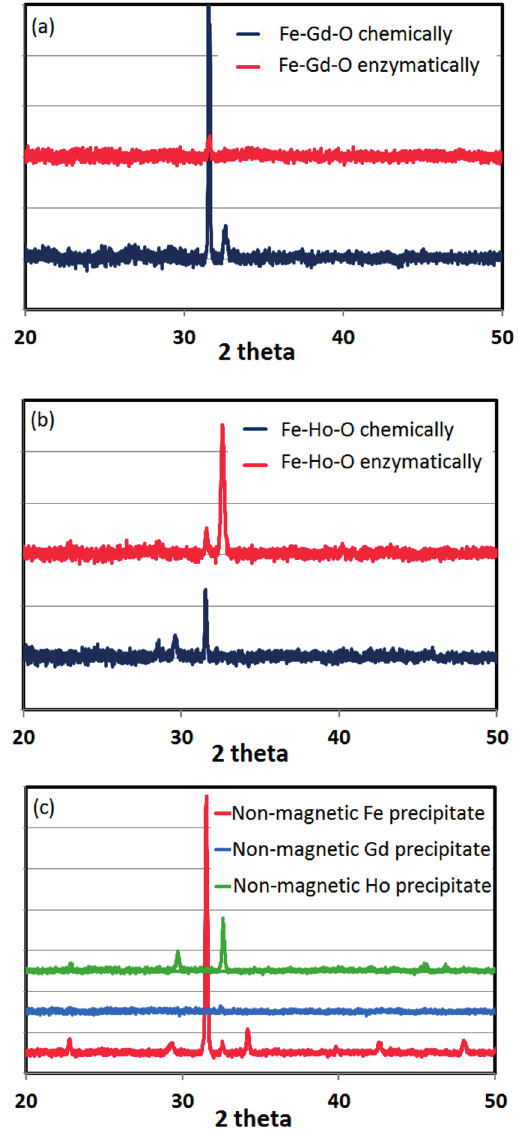
Figure 9. XRD patterns of the ( a ) Fe–Gd–O MNPs; ( b ) Fe–Ho–O MNPs; and ( c ) non-magnetic precipitates obtained by reduction of the chlorides of iron, gadolinium, and holmium. The nanoparticles were further characterized by vibrating sample magnetometry (VSM), and the magnetization curves at 300 K for chemically-synthesized and enzymatically-synthesized nanoparticles are shown in Figure 10. In all of these cases, the particles exhibit paramagnetic behavior, since the magnetization increases linearly with increasing magnetic field. At low temperature (5 K), the nanoparticles maintained strong magnetic behavior (Figure 11) and exhibited a significantly higher saturation magnetization of 100 and 45 emu/g for chemically- and enzymatically-synthesized Fe–Gd–O MNPs, and of 50 and 30 emu/g for Fe–Ho–O MNPs. At 300 K, they are paramagnetic; that is, magnetic only under the influence of a magnetic field. At 5 K, each material (regardless of the composition and synthesis method) shows strong magnetic properties with a small coercivity (17–20 Oe) and negligible residual magnetization (0.02 to 0.07 emu/g). The saturation magnetization data are summarized in Table 1 along with coercivity and residual magnetization